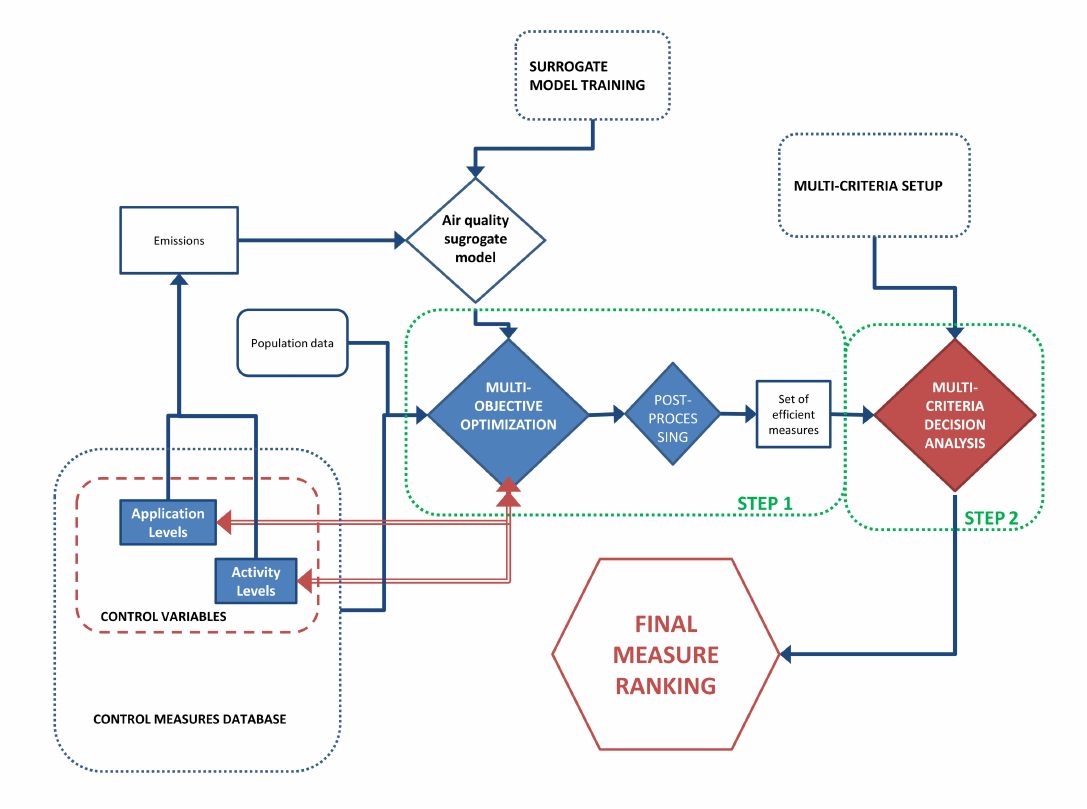
Figure 1. Scheme of the decisional problem